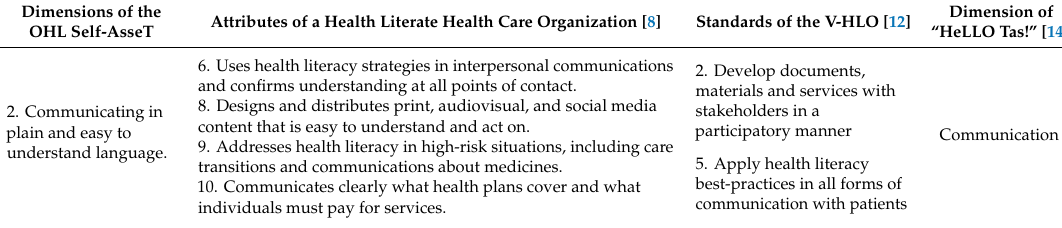
Table 1. Example of a dimension’s